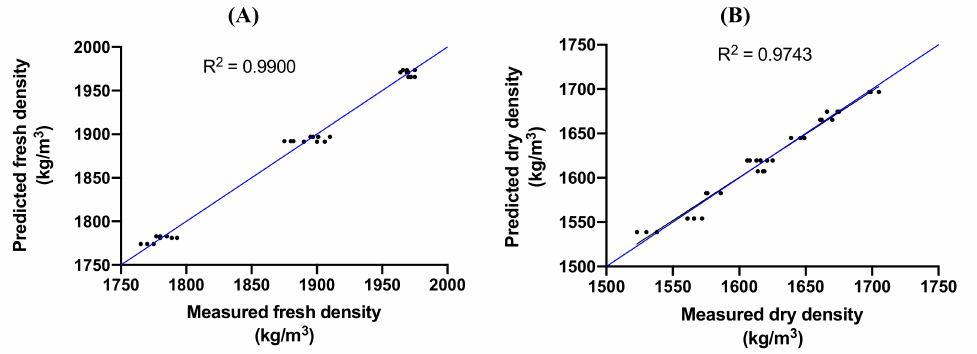
Figure 14. Predicted versus measured ( A ) fresh density and ( B ) dry density of backfill specimens. The ANOVA results for both models and their coefficients (Tables 10 and 11) sug- gest that entrained air dosage strongly influences the fresh and dry densities of backfill specimens. The negative coefficient terms of A and A 2 in Equation (8) explain the de- crease in fresh density when the entrained air dosage is increased. The dry densities are similarly